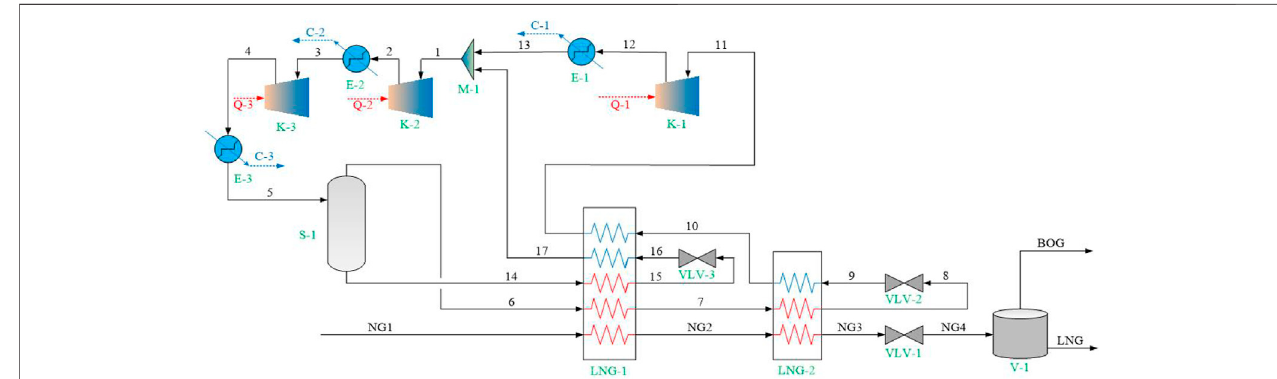
FIGURE 3 | HYSYS simulation of improved NG liquefaction